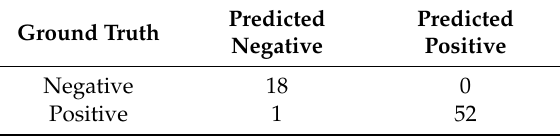
Table 6. Confusion matrix for the test set.